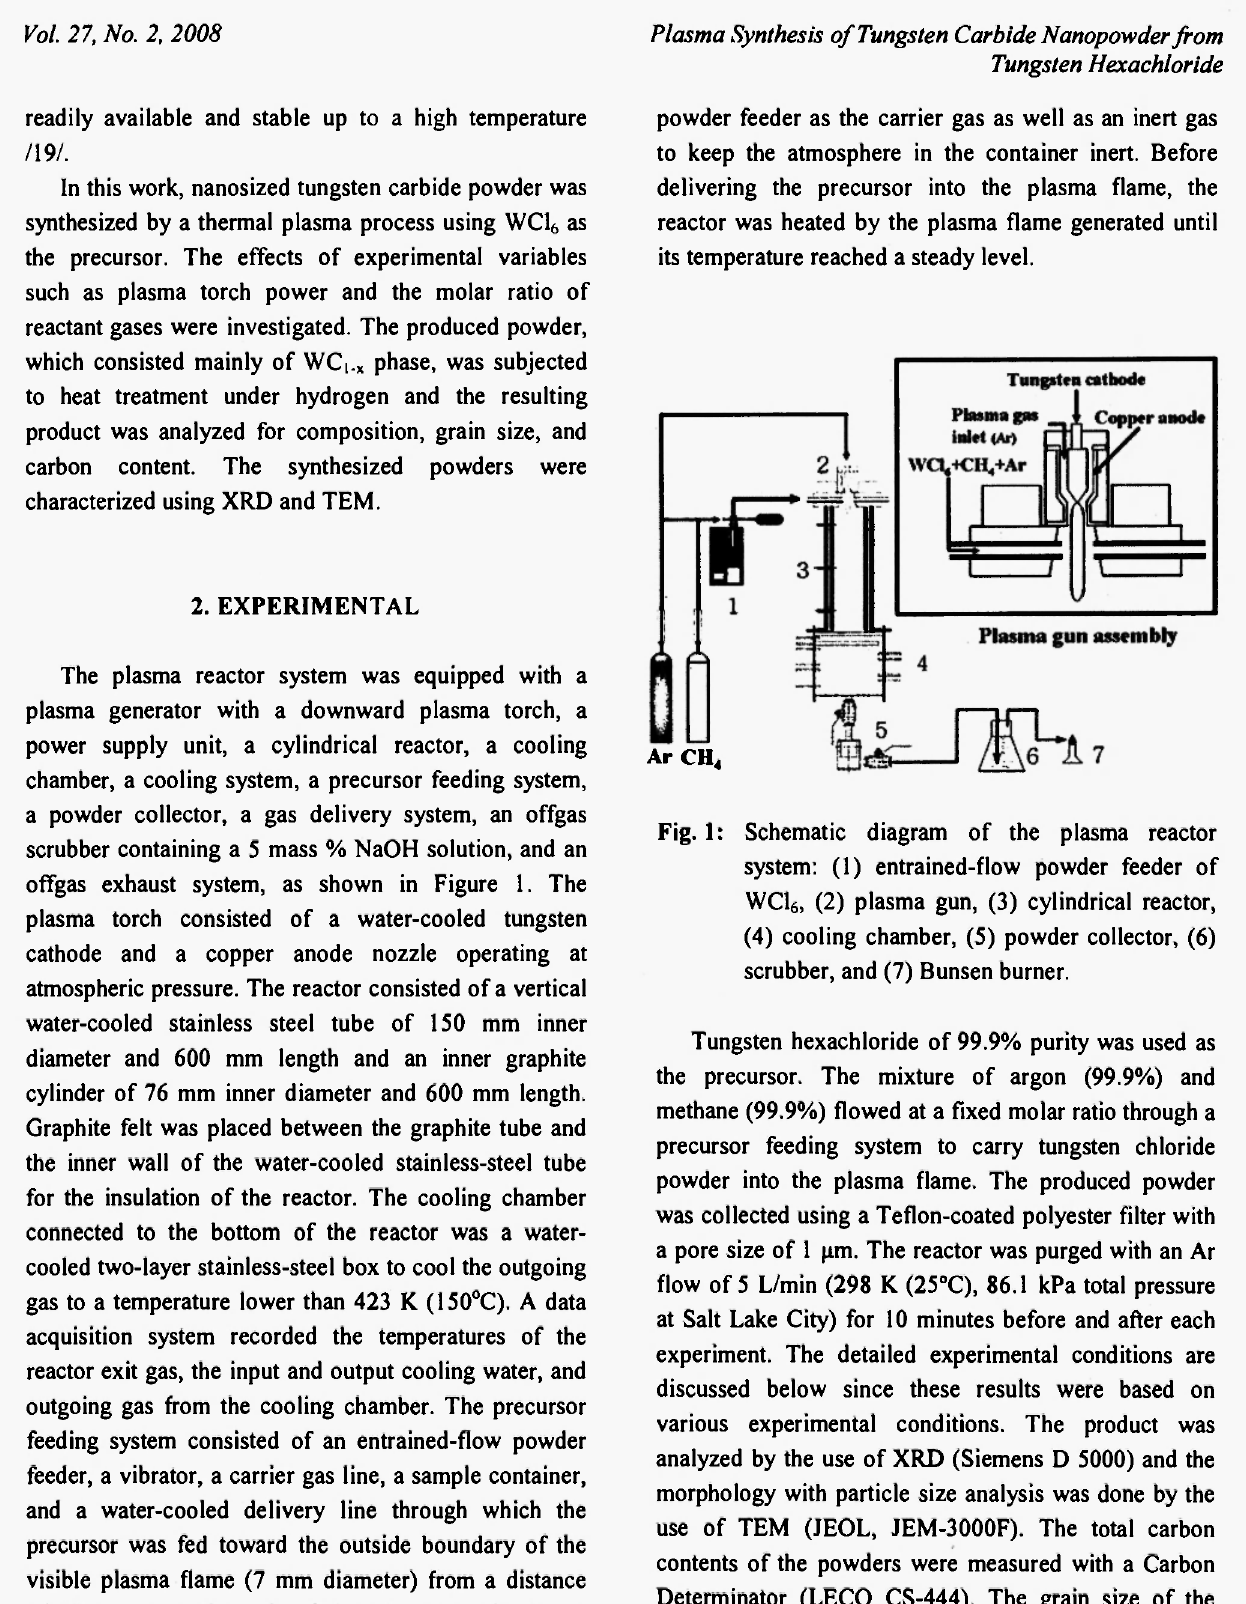
Fig. 1: Schematic diagram of the plasma reactor system: (1) entrained-flow powder feeder of WC1 6 , (2) plasma gun, (3) cylindrical reactor, (4) cooling chamber, (5) powder collector, (6) scrubber, and (7) Bunsen